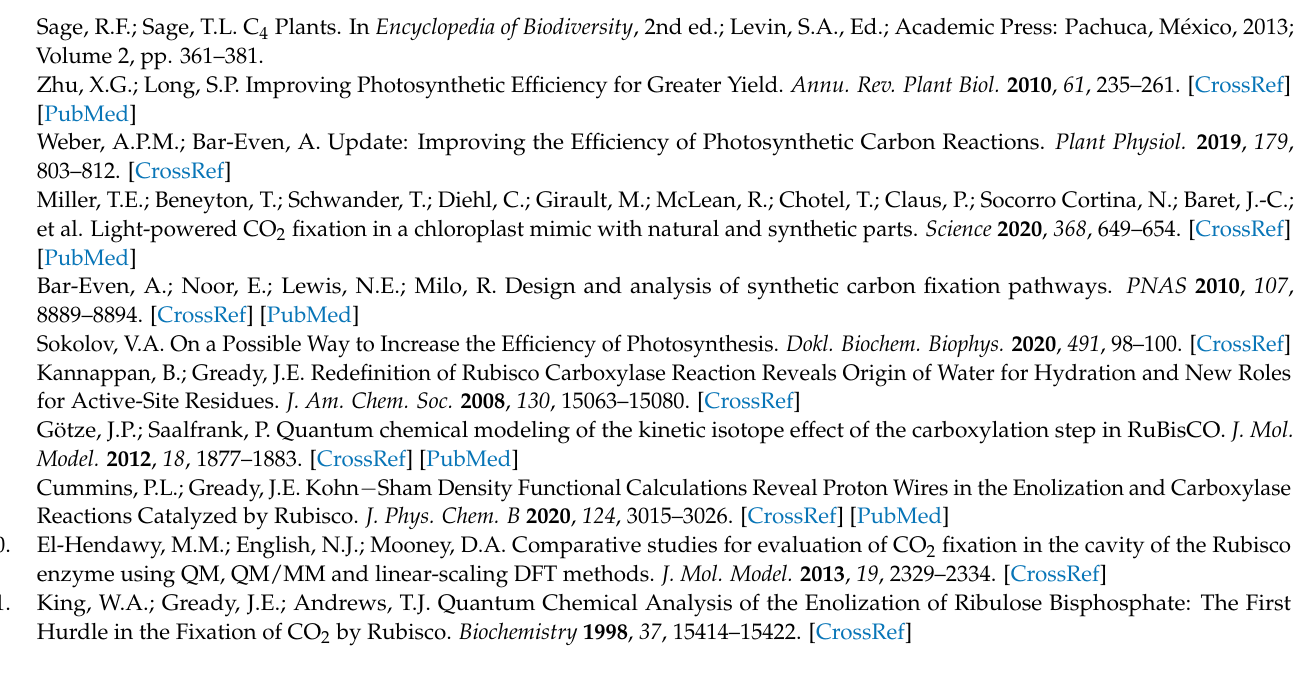
cies. ( b ) The scheme of state (6) is pictured in Figure 5a.